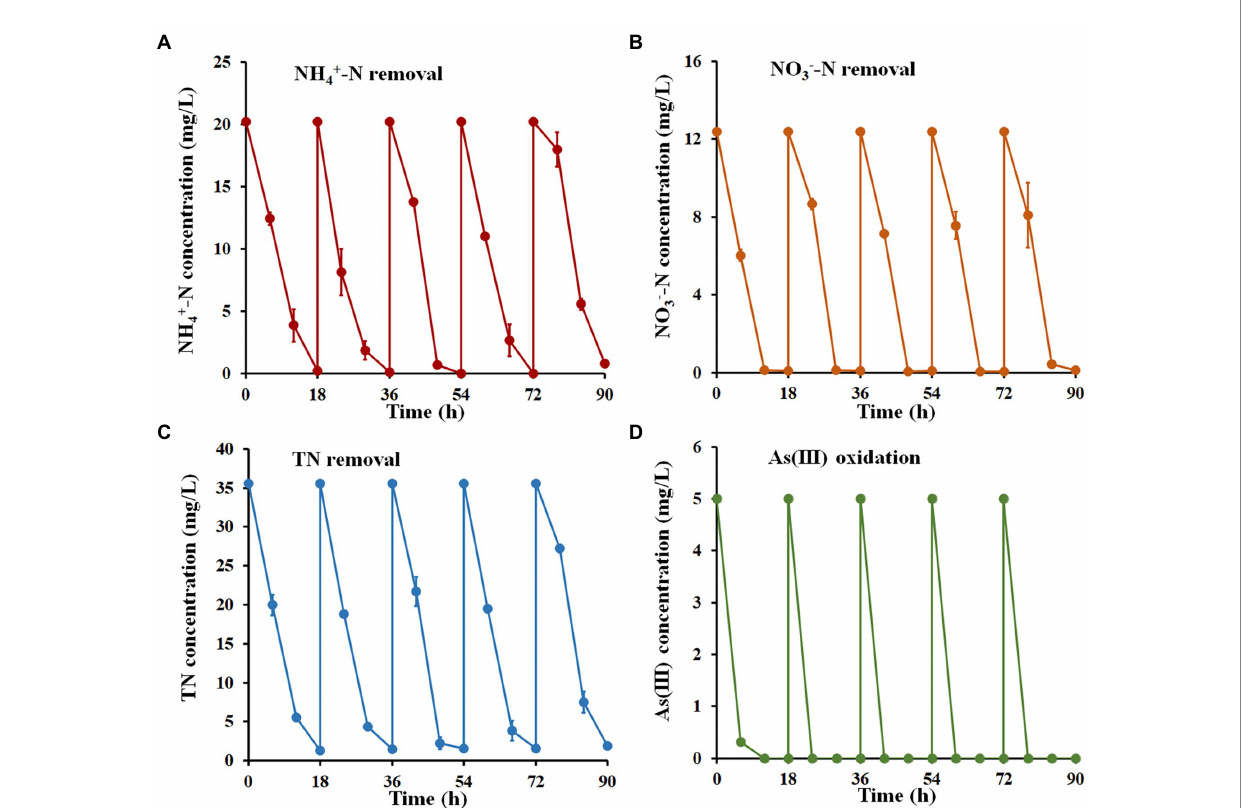
FIGURE 5 Nitrogen removal and As(III) oxidation by strain H7 in wastewater from batch-to-batch cycles. NH 4+ -N (A) , NO 3 − -N (B) , TN (C) removal, and As(III) oxidation (D) curves of strain H7. Error bars represent the mean ± standard deviation ( n =